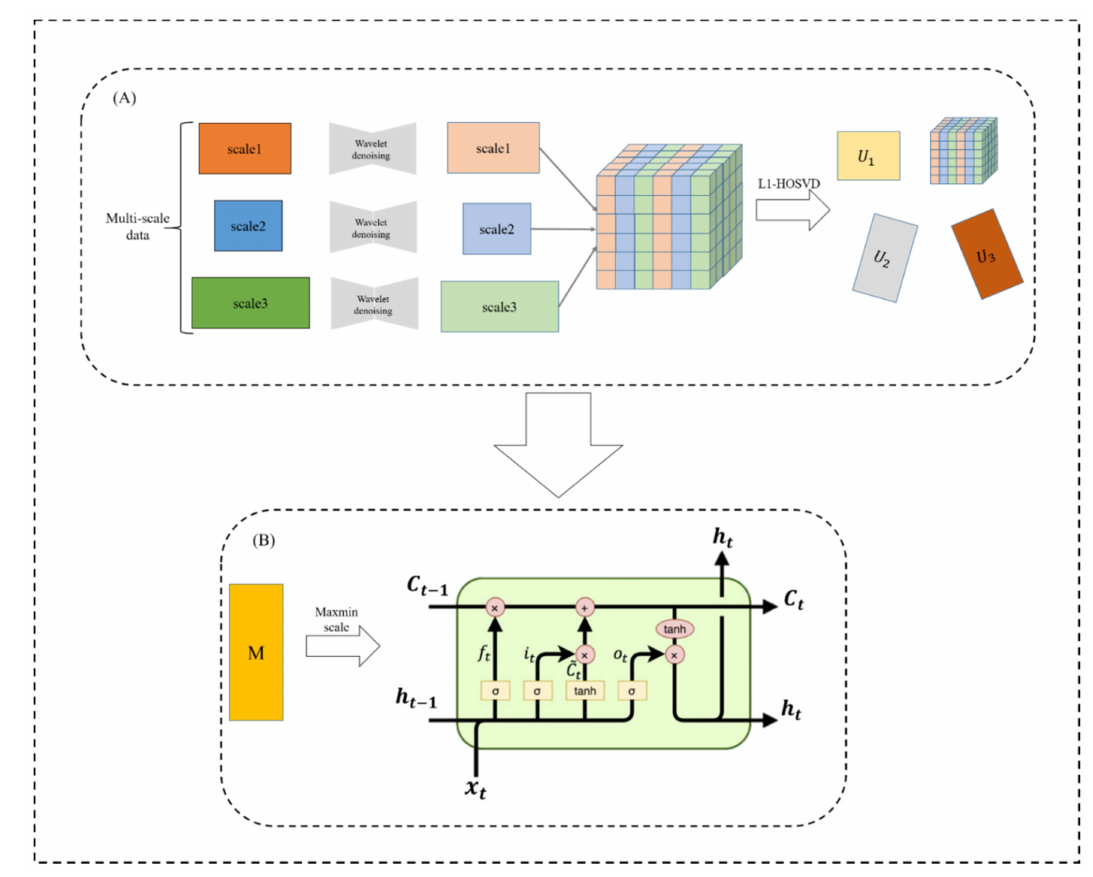
Figure 4. ( A ) A wavelet transform is used for denoising and tensor fusion in multiscale data fusion. ( B ) LSTM is used for regression prediction, and matrix M is transformed from the reconstruction